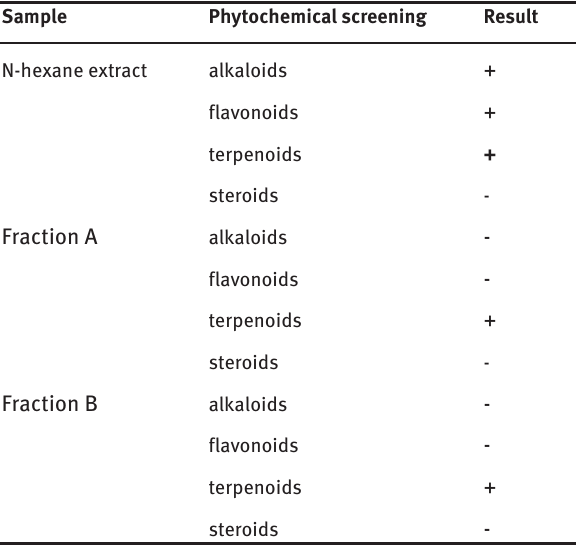
Table 1 : Phytochemical screening of n-hexane extract and major compunds.